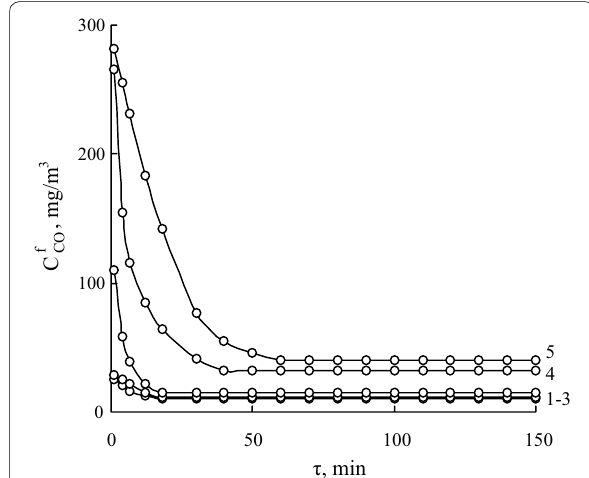
Fig. 6 Time dependence of C f CO in the course of CO oxidation with air oxygen at different thermodynamic activities of water contained in К 2 PdCl 4 –Cu(NO 3 ) 2 –KBr/3H–CLI samples a H 2 O : 0.26 ( 1 ), 0.79 ( 2 ), 0.87 ( 3 ), 0.93 ( 4 ), 1.0 ( 5 ). C Pd(II)